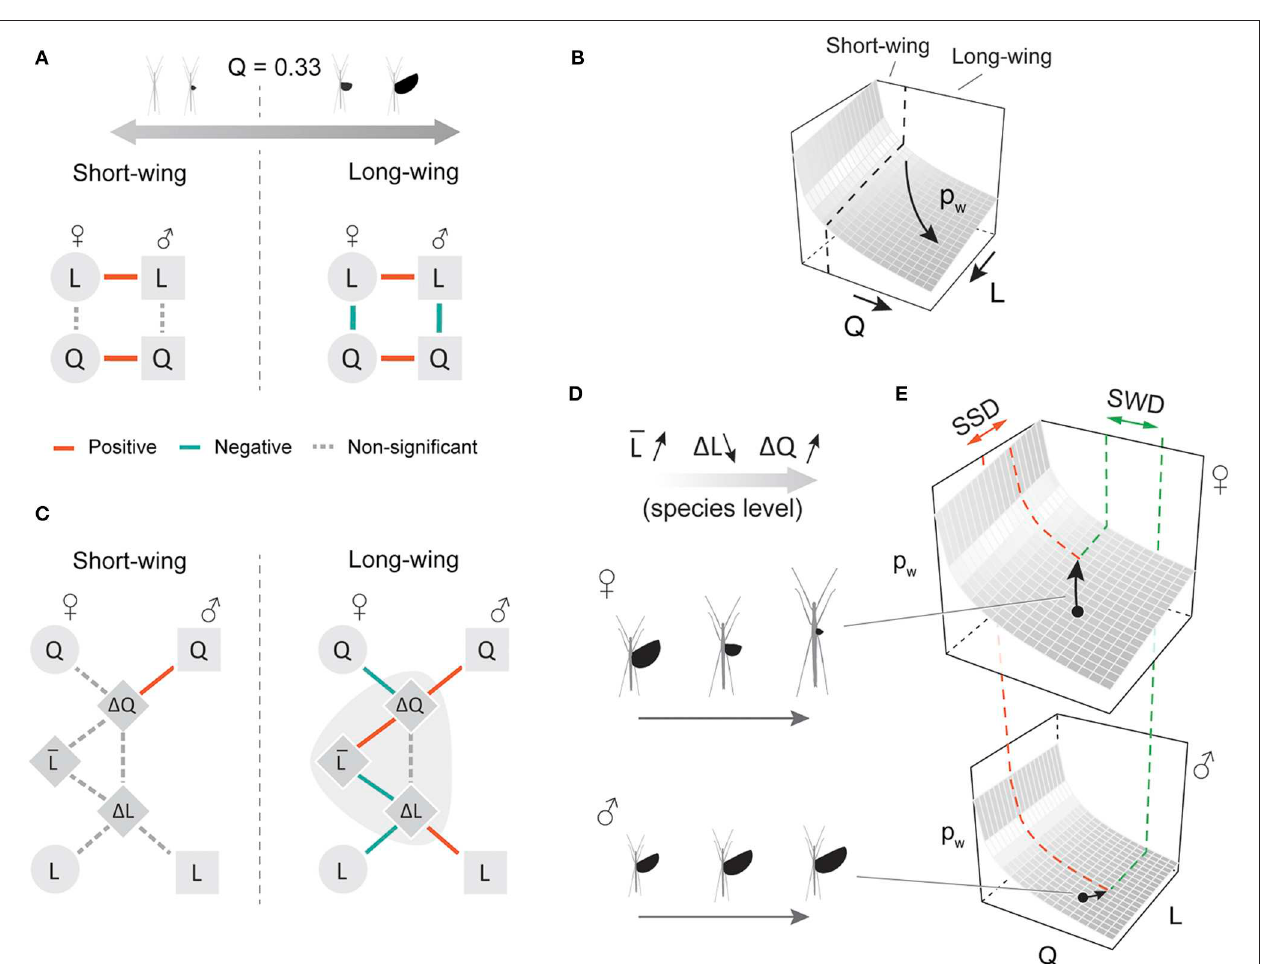
Frontiers in Ecology and Evolution |